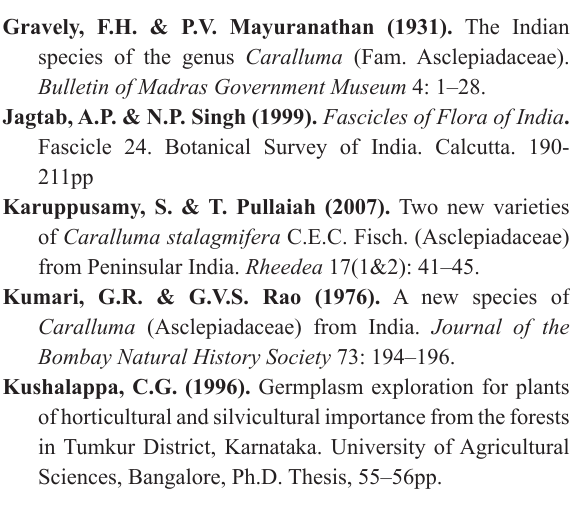
Figure 1. Location of C. stalagmifera var. longipetala in Chitradurga